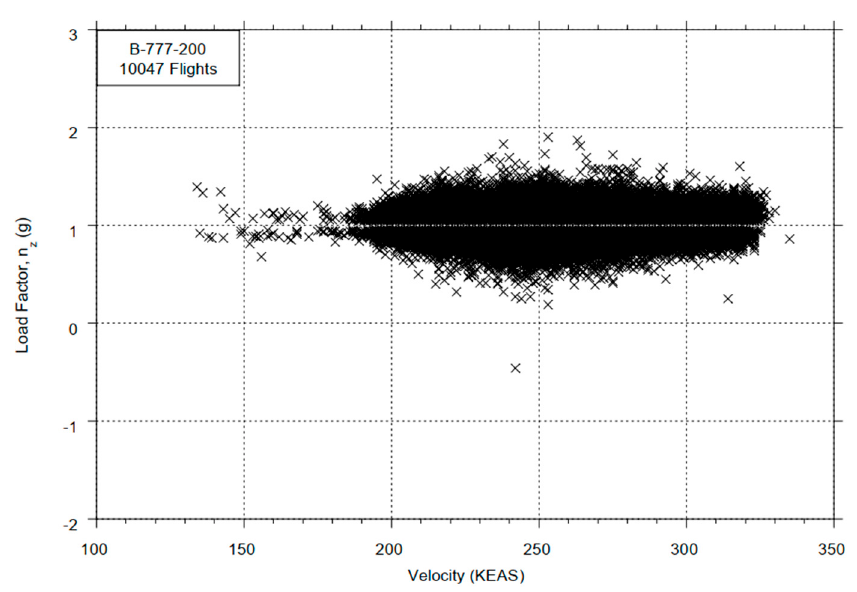
Figure 34. Acceleration data of a Boeing 777-200ER